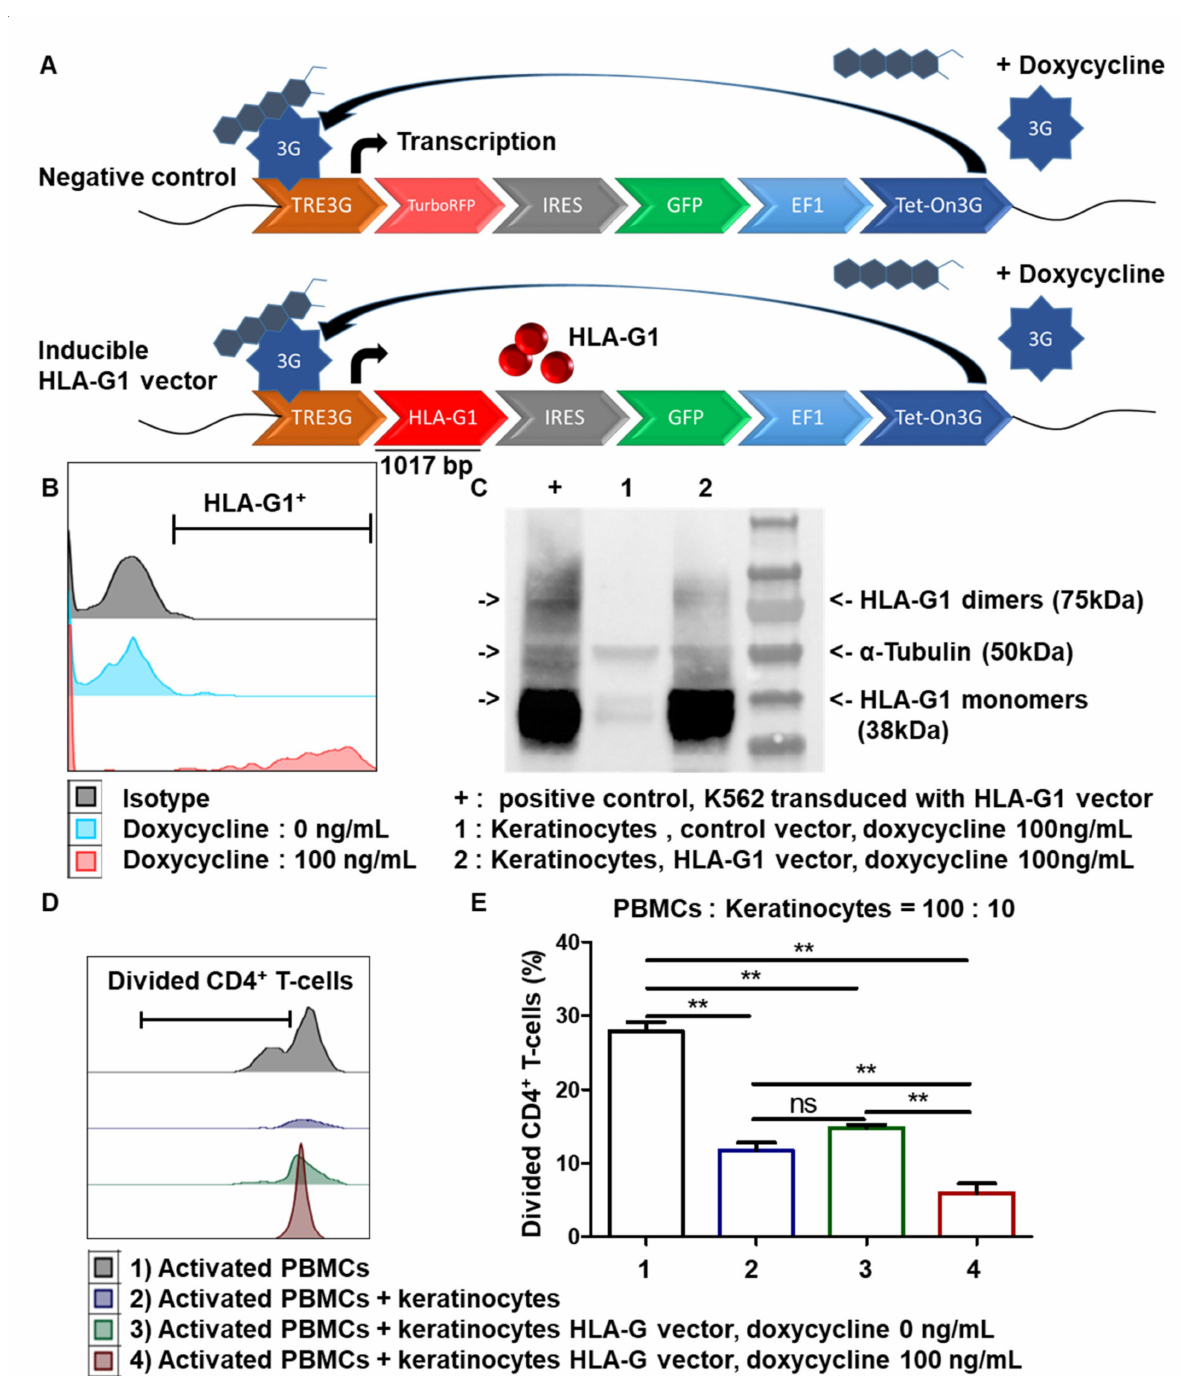
Figure 6. Inducible expression of HLA-G1 increases immunomodulation by amplifying keratinocytes. ( A ) Construction of vectors allowing inducible expression of HLA-G1 by keratinocytes. ( B , C ) Transduced cells from 1 representative donor were cultivated for 7 days after transduction. HLA-G1 expression on keratinocytes was induced by doxycycline. ( B ) Representative profiles of HLA-G1 expression on transduced cells. ( C ) Typical gel photograph corresponding to different cultures, with α -tubulin detection as loading control. K562 cells transduced with HLA-G1 were used as positive control with 4H84 antibody. ( D , E ) In total, 10,000 keratinocytes, transduced or not with HLA-G vector, were incubated with 100,000 PBMCs for 7 days. PBMCs were pre-marked with a proliferation dye. PBMCs were activated by CD3 + CD28 + beads. PBMC proliferation was quantified by dye decrease at day 7. ( D ) Representative flow cytometry profiles at day 7. ( E ) CD4+ T-cell proliferation depending on presence of keratinocytes and HLA-G1 (mean + SEM, p < 0.05, n = 3). Exact p-values were determined using the t -test **: p < 0.01, n =